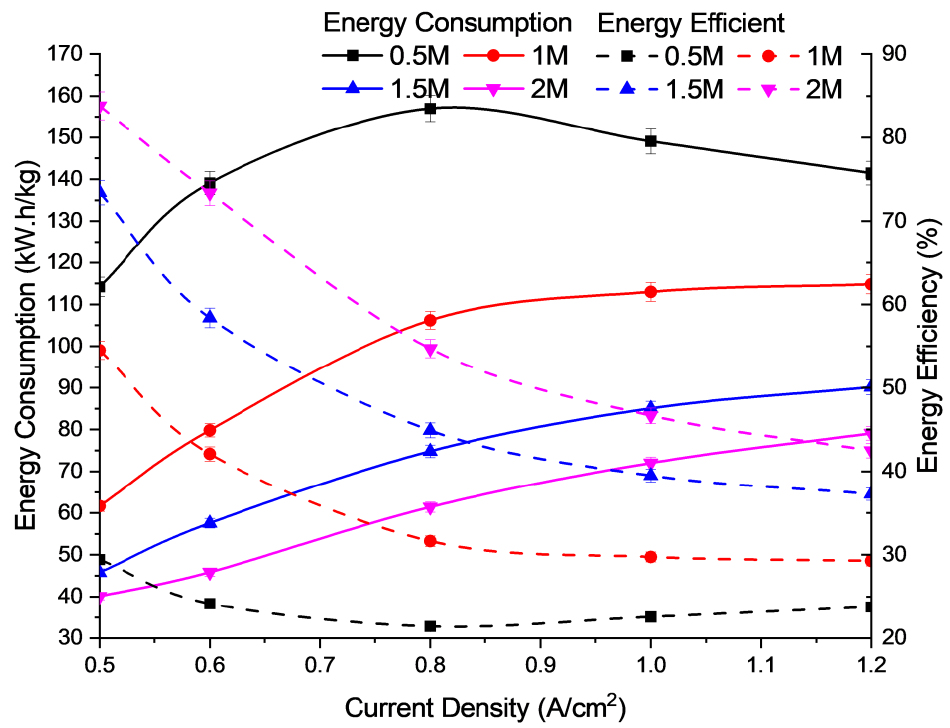
Figure 4. Profile of energy consumption and energy efficiency of electrolysis performance for different alkaline concentrations at 6 mL/min flow rate and 30 ◦ C in operating